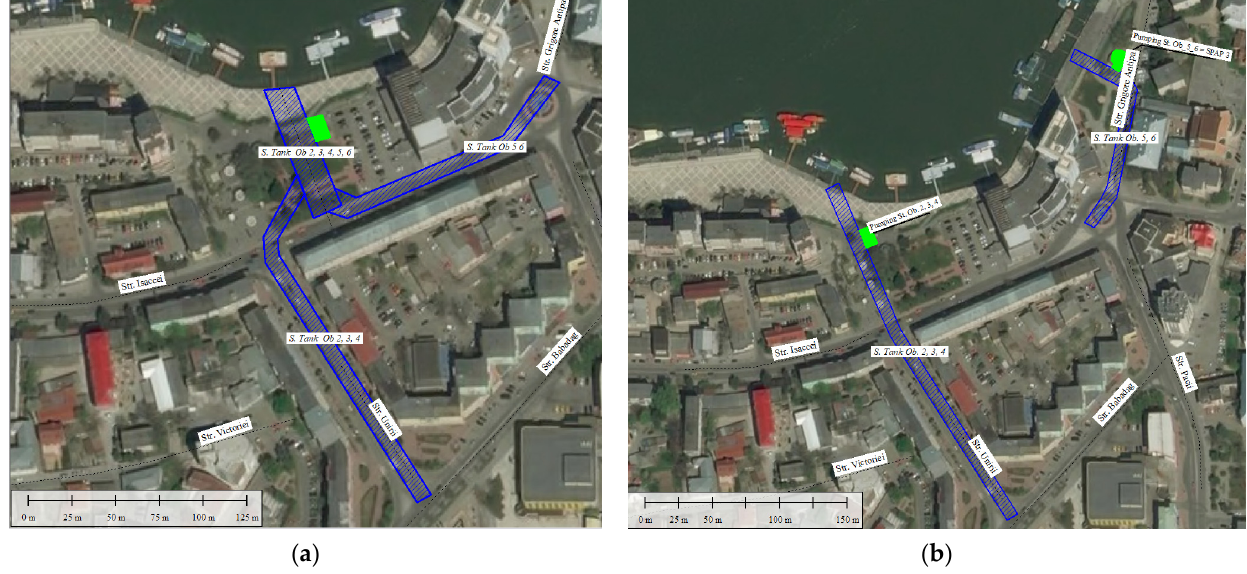
Figure 22. Proposed solutions for flood mitigation: ( a ) Solution-1 and ( b ) Solution-2. Legend: blue line = proposed tanks; green rectangle = pumping station.